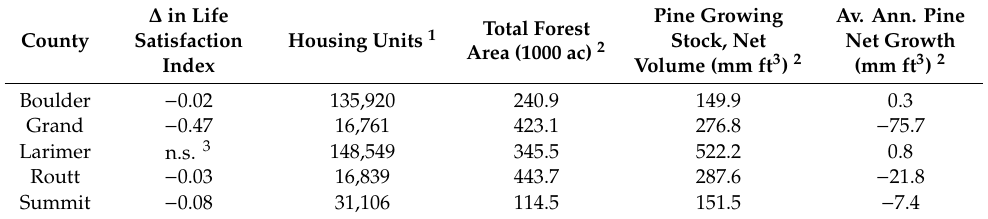
Table 3. Estimated change in life satisfaction, housing, and general forest characteristics for MPB counties in